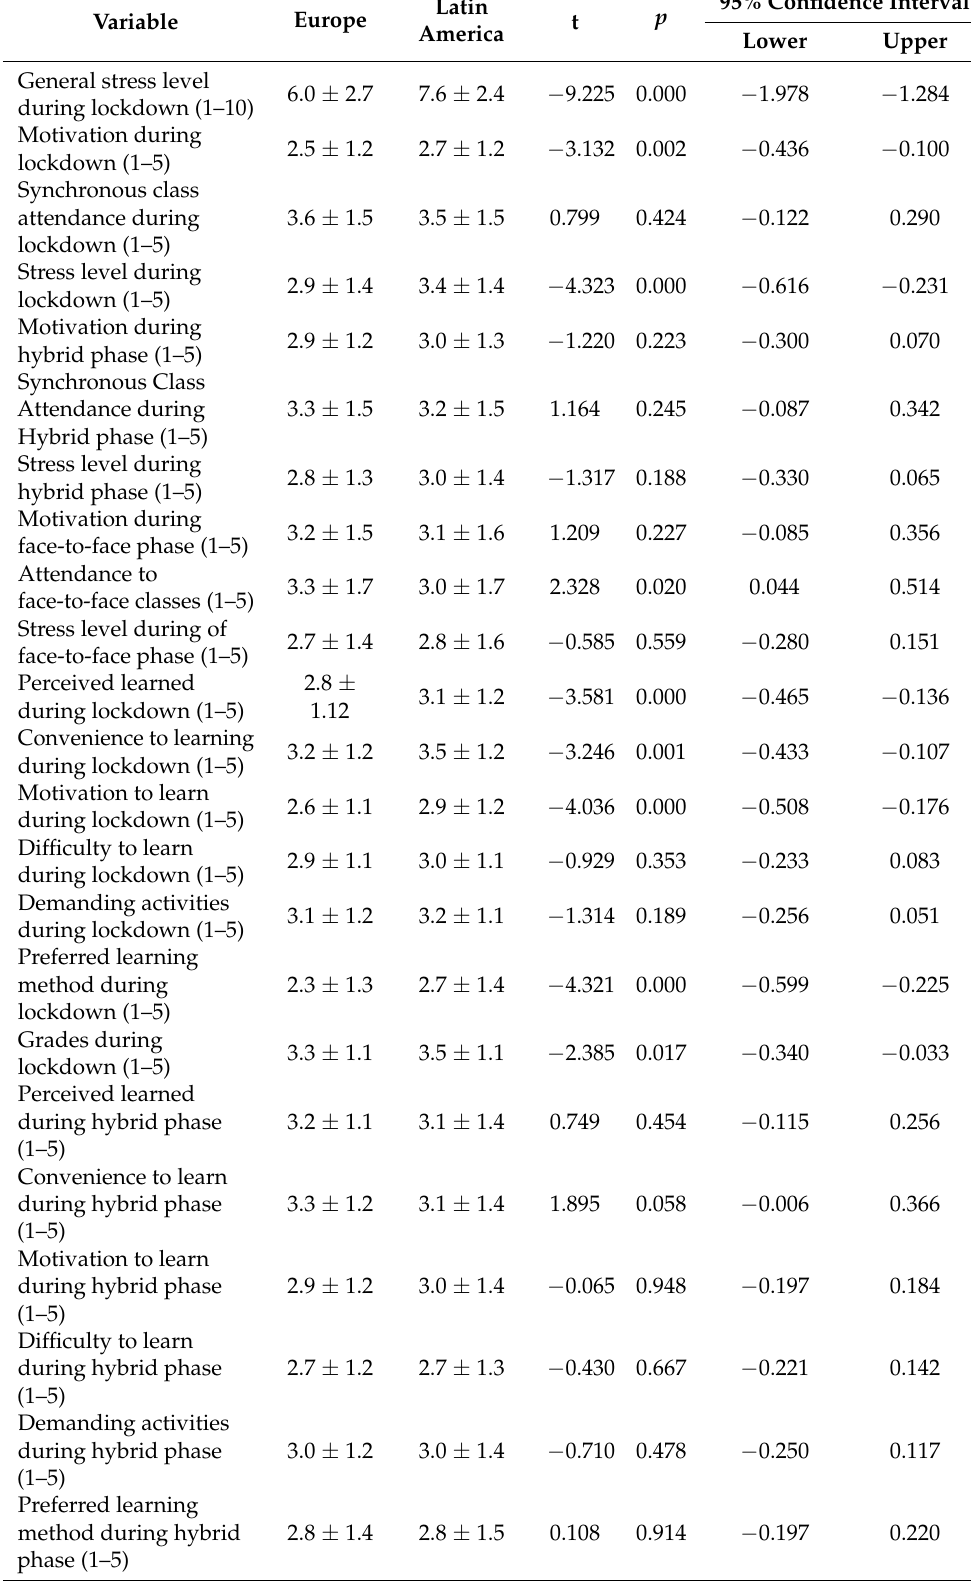
Table 1. Differences between regions in the variables of perception of academic quality during the